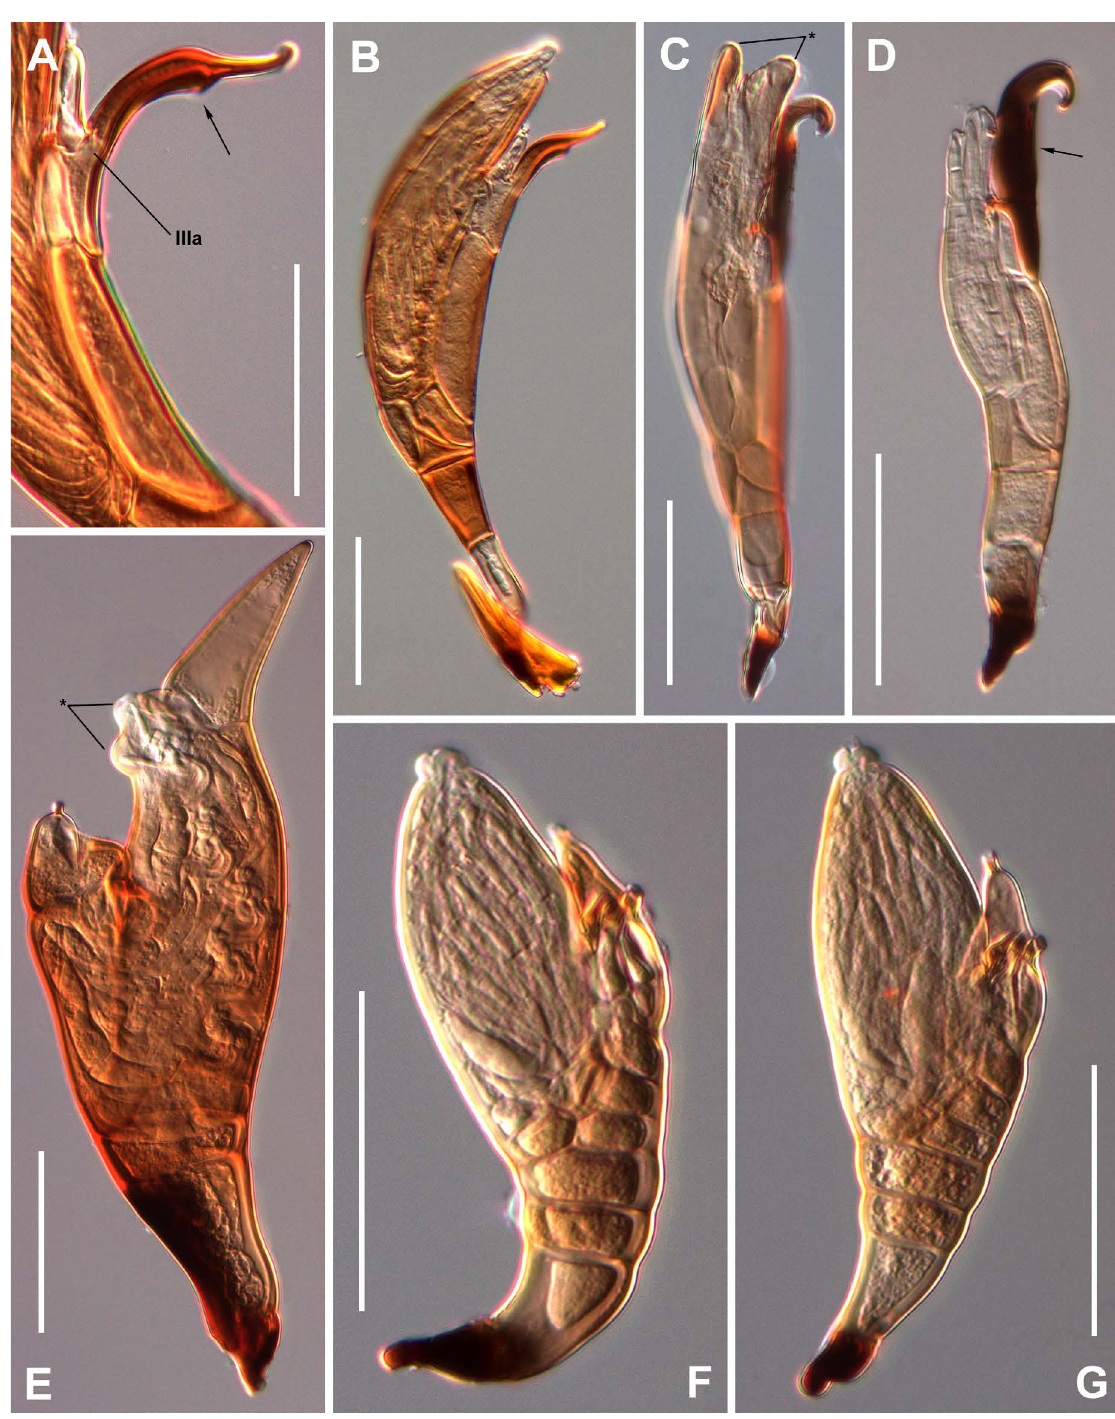
Fig. 21. A – B . Chitonomyces italicus Speg. A . Detail of cell IIIa and its outgrowth (arrow). B . Mature thallus. – C – D . Chitonomyces melanurus Peyr. C . Mature thallus showing perithecial enlarged lips (*). D . Young thallus with labelled cell IIIa and hooked basal cell of primary appendage (arrow). – E . Chitonomyces paradoxus (Peyr.) Thaxt. Mature thallus showing prominent perithecial lips (*). – F – G . Hydraeomyces halipli (Thaxt.) Thaxt. Mature thalli. Scale bars: 50 µm. Photographs from